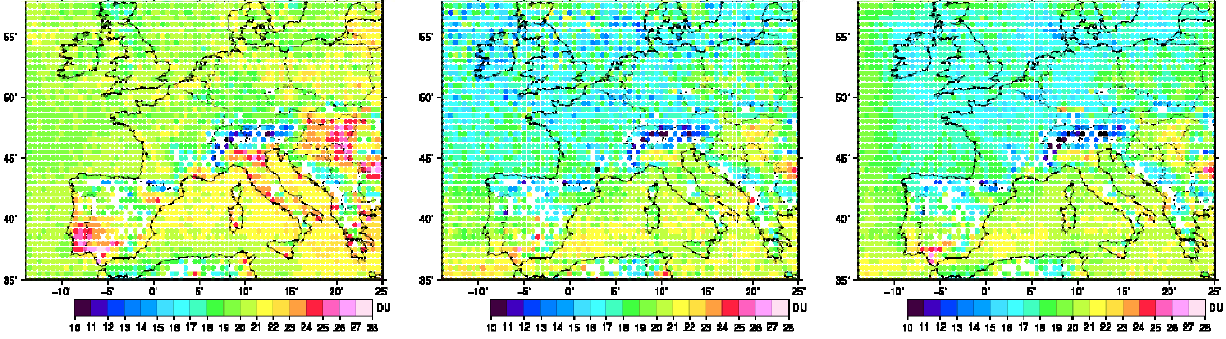
Fig. 5. 0–6km ozone partial columns (Dobson Units) from the mean of the forecast ensemble (i.e. before assimilation; left panel), from IASI retrievals (central panel) and the mean of analysis ensemble (i.e. the ensemble after assimilation; right panel). Values are averaged over the whole month at 09:00 a.m. The white points on the maps correspond to the missing pixels (clouds or bad inversion) (color scale varies from black, representing relatively low values, to pink representing relatively high